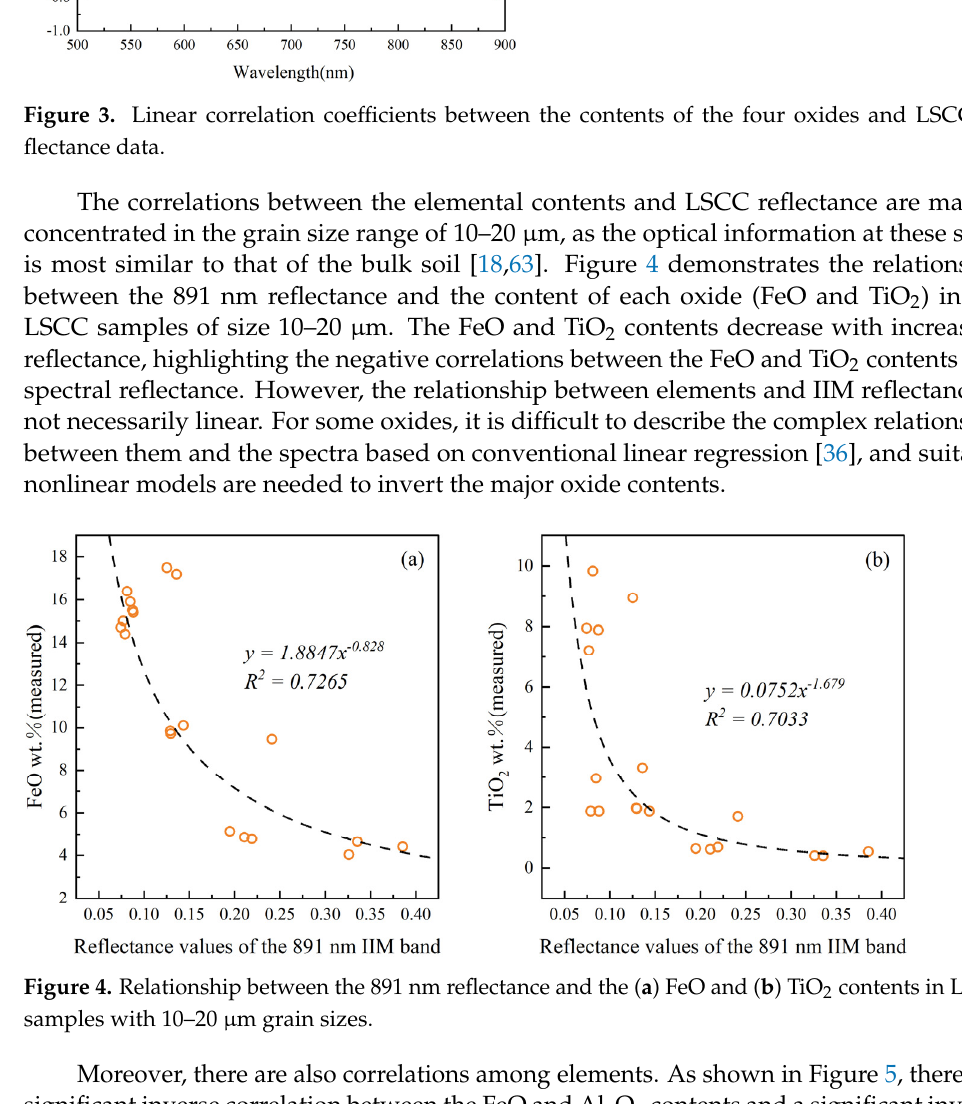
Figure 5. Correlations between ( a ) FeO and Al 2 O 3 and ( b ) TiO 2 and SiO 2 in the LSCC samples with 10–20 μ m grain sizes. Figure 6 shows the correlations between the reflectance band differences and the ma- jor oxides, and the color of each point in the figure indicates the magnitude of the corre- lation coefficient between the band differences and the oxide contents. The results show that the band differences display the highest correlations with FeO and Al 2 O 3 and the lowest correlations with TiO 2 and SiO 2 . The maximum value of the correlation coefficient between FeO and the band difference is located at 541 nm–532 nm (0.861); most of the correlation coefficients between Al 2 O 3 and the band difference of IIM are approximately 0.80, and the maximum value is 0.870. Additionally, the correlation between TiO 2 and the band difference of IIM decreases from the lower left to the upper right corner, and the maximum value appears at 532 nm–522 nm (0.710). The correlation between SiO 2 and the band difference is poor, with a maximum value of 0.427, and most of the correlation coef- ficients are approximately 0.40. In general, for the four oxides, the high correlations are mainly concentrated in the lower left corner, and the band differences among the longer